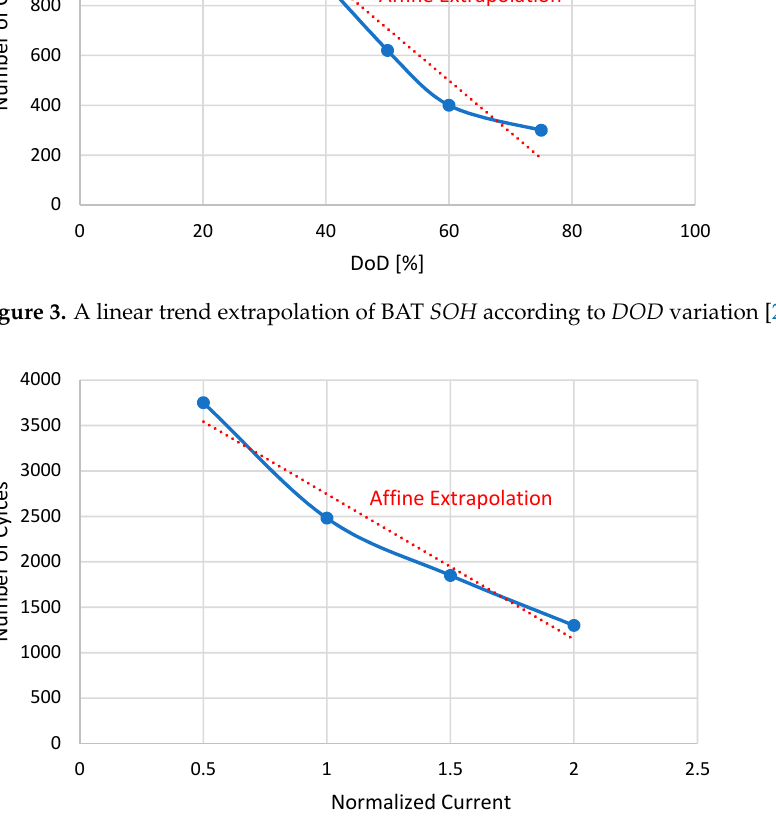
Figure 4. A linear trend extrapolation of BAT SOH according to normalized current variation [28].